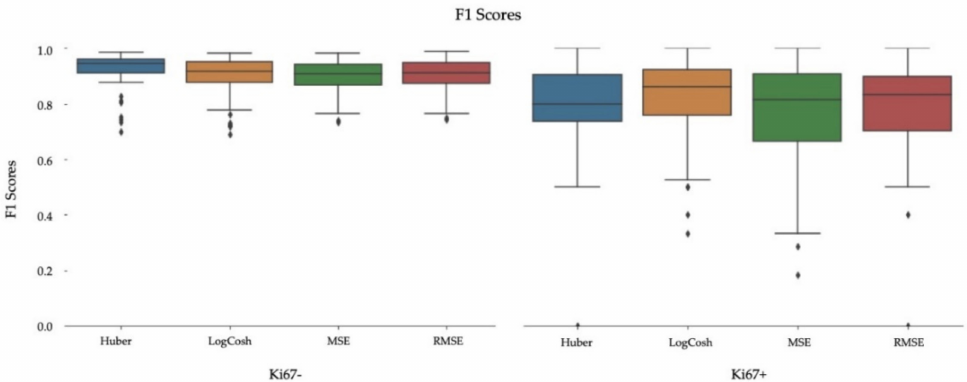
Figure 9. F1 scores on the SMH patches dataset, per stain Ki67 − (Hematoxylin) and Ki67+